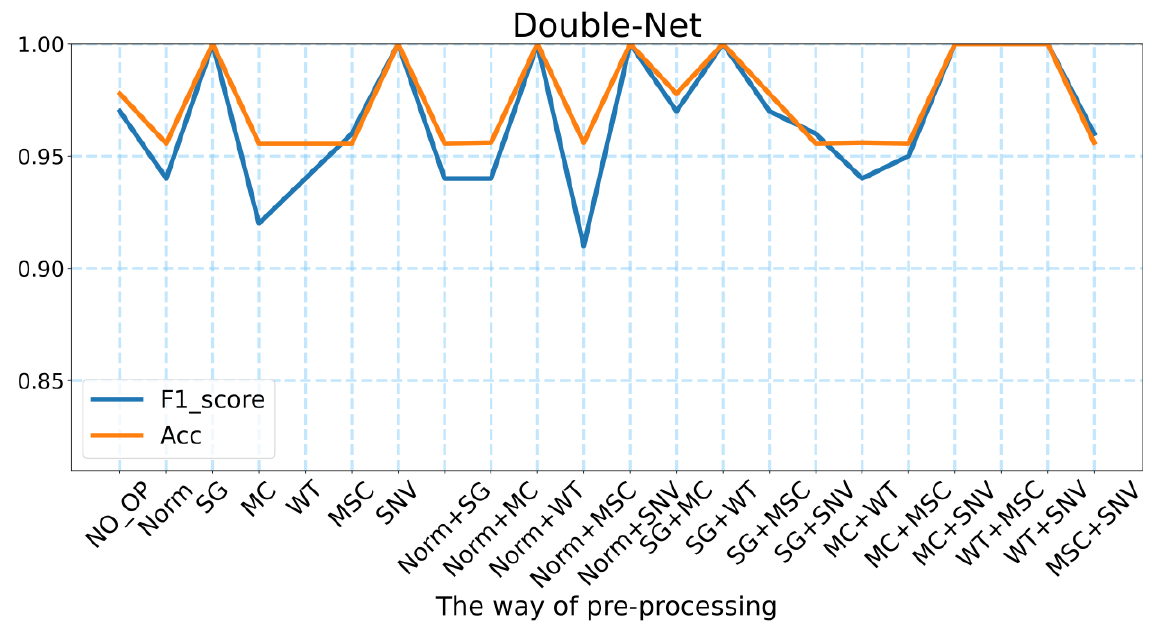
Figure 5. The accuracy and F1_score of Double-Net under different pre-processing methods.